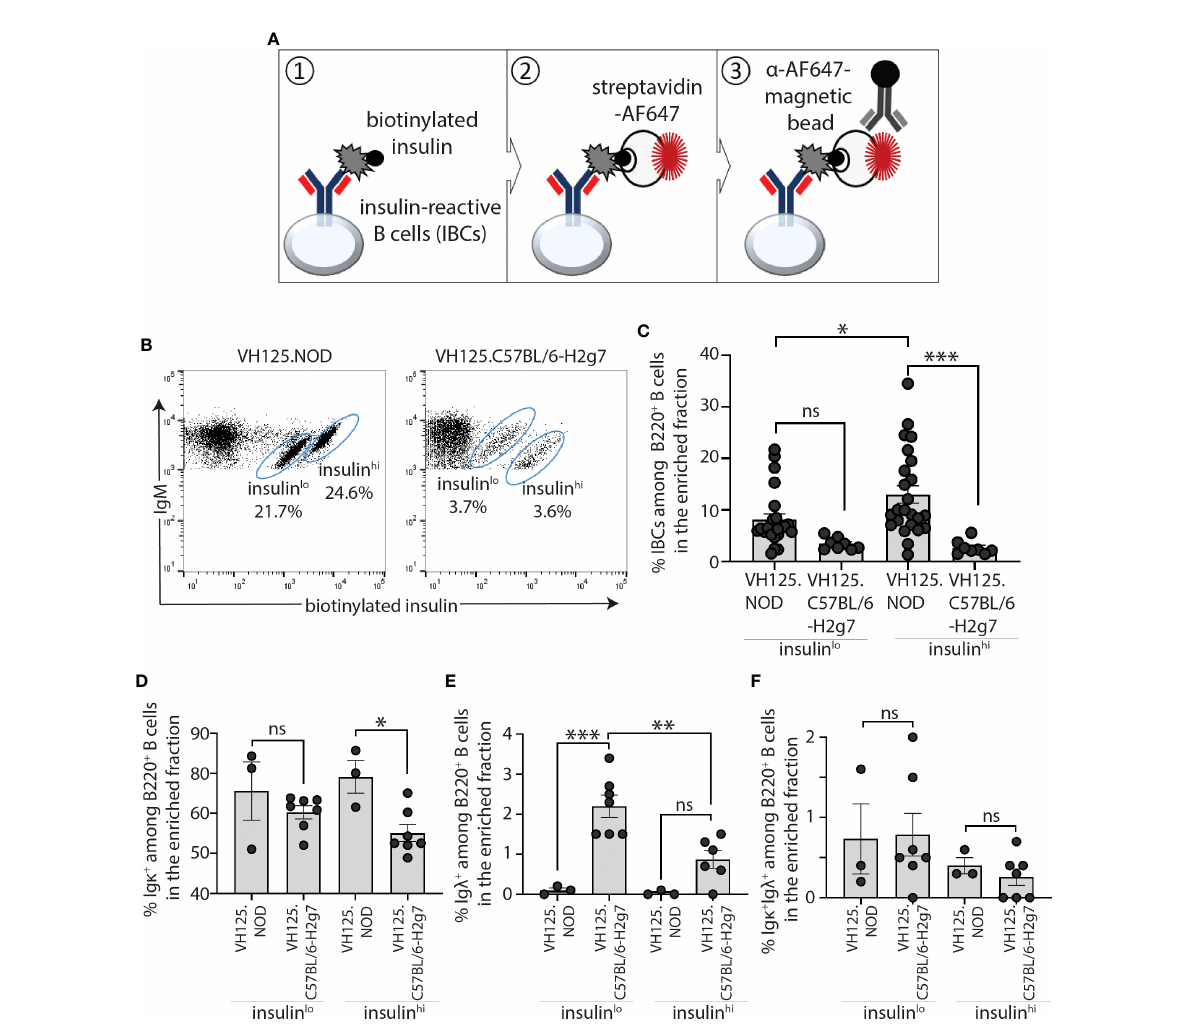
FIGURE 1 IBCs expressing Ig k accumulated in spleen of prediabetic VH125.NOD compared to diabetes-resistant VH125.C57BL/6-H2g7 mice. (A) Diagram representing magnetic bead-based methodology for enrichment of IBCs. (B, C) Frequency of splenic IBCs in the enriched fraction in prediabetic VH125.NOD and diabetes-resistant VH125.C57BL/6-H2g7: representative fl ow cytometric panels of IBCs gated on lymphocytes/singlets/live cells/B220 + IgM + cells are shown (B) and frequencies of the two IBC populations with insulin MFI low (insulin lo ) and high (insulin hi ) across multiple experiments are shown (VH125.NOD – n=24, VH125.C57BL/6-H2g7 – n=8) (C) . (D – F) Cell surface expression of immunoglobulin kappa (Ig k + ) (D) , lambda (Ig l + ) (E) , and double positive kappa and lambda (Ig k + Ig l + ) (F) on insulin lo and insulin hi IBCs in VH125.NOD (n=3) and VH125.C57BL/6-H2g7 (n=7). Results are pooled from at least three independent experiments and represented as the mean ± SEM. Each dot represents a mouse. One-way ANOVA followed by post hoc Tukey ’ s multiple comparisons tests for panels (C – F) were used to determine the signi fi cance of differences among groups and de fi ned as *P < 0.05, **P < 0.005, ***P < 0.0005. ns, no statistical signi fi